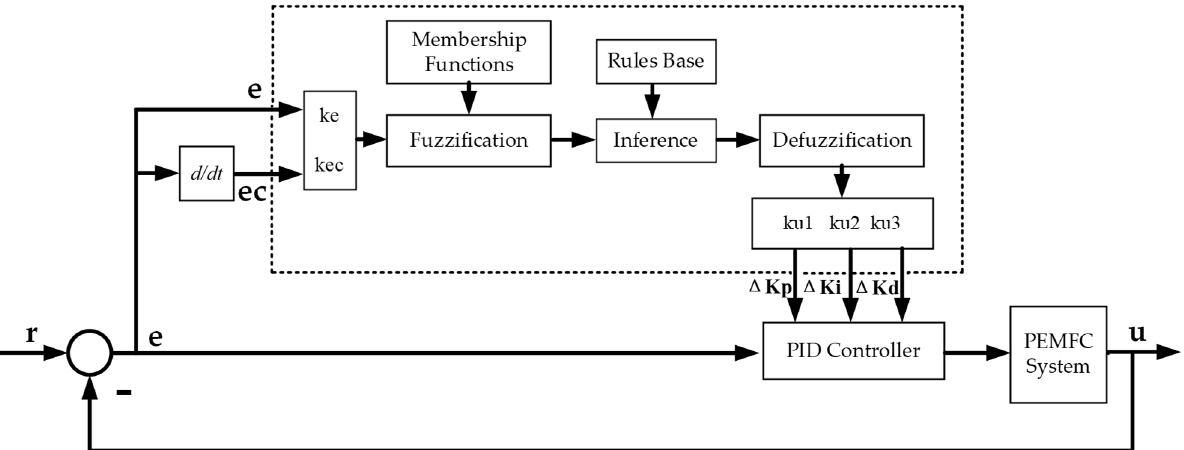
Figure 3. The adaptive fuzzy PID controller architecture.